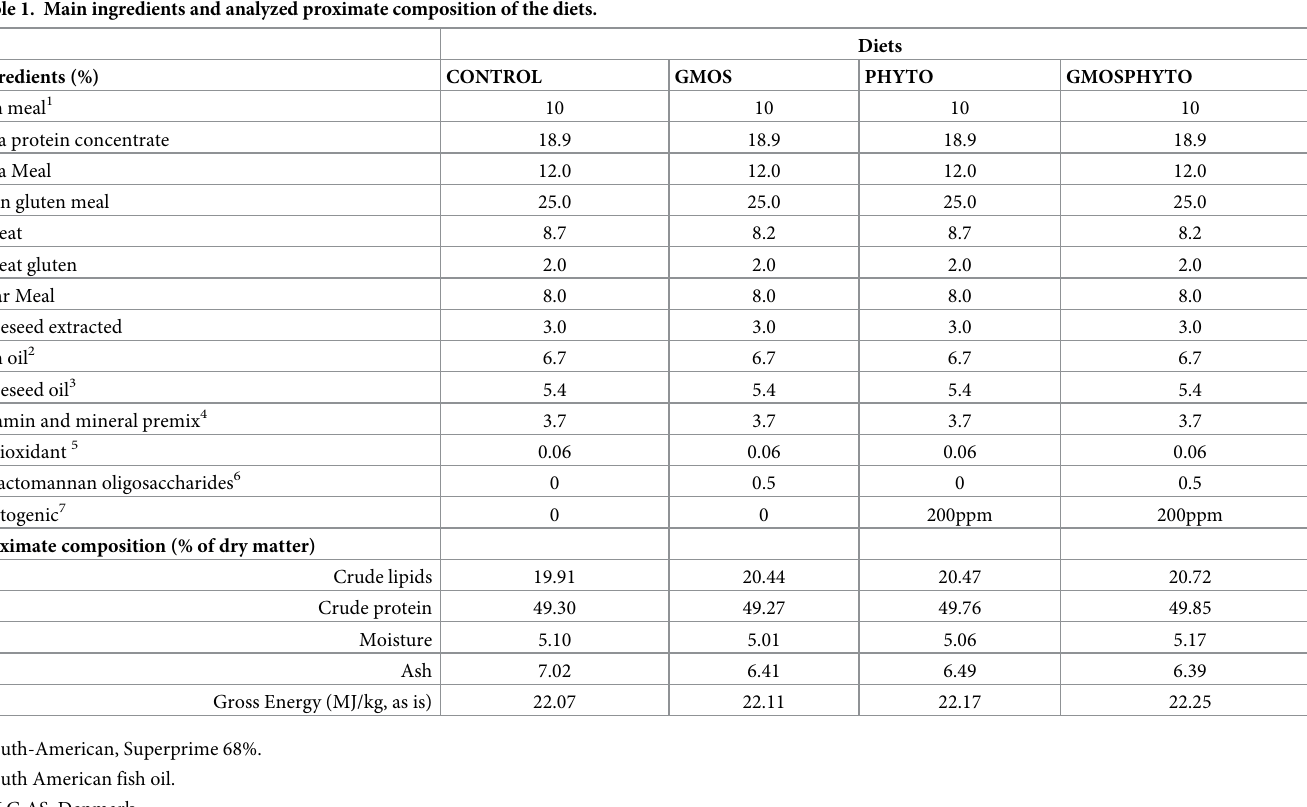
Table 1. Main ingredients and analyzed proximate composition of the